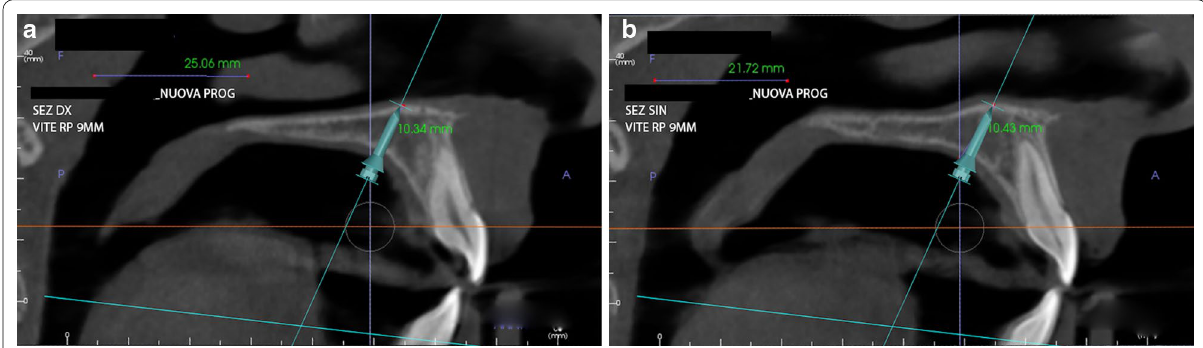
Fig. 1 a , b Planning of miniscrews insertion on CBCT